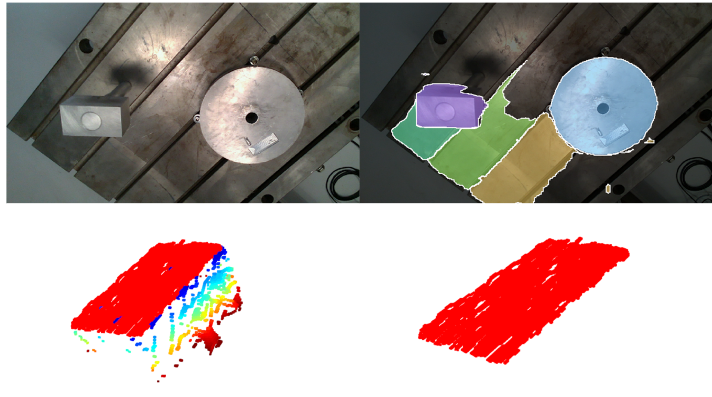
Figure 6. The images from the RGB-D camera’s view of the various stages in the experiment.